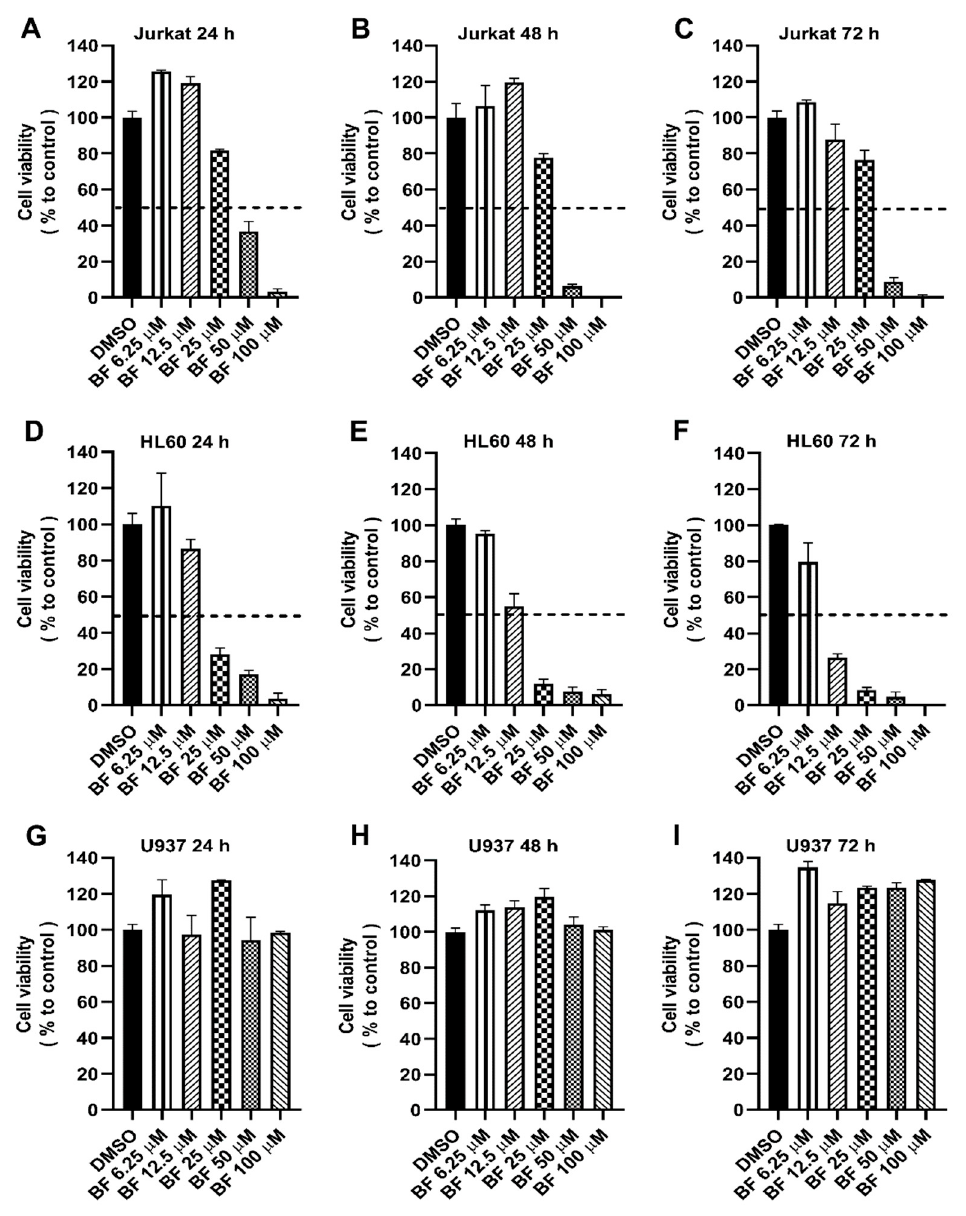
Figure 4. MTS assay on three different leukemia cell lines: Jurkat ( A – C ), HL60 ( D – F ), and U937 ( G – I ). Cell availability has been tested for 24, 48 and 72 h by incubating the cells in a 96-well plate with different concentrations of BF (Bacillamide F) (6.25–100 µM). The percentage of control samples (DMSO, 100%) is shown as means ± SDs ( n = 3, biological replicates). The experiments were repeated at least twice independently with similar results, and the representative data from one experiment are shown ( n = 3, biological